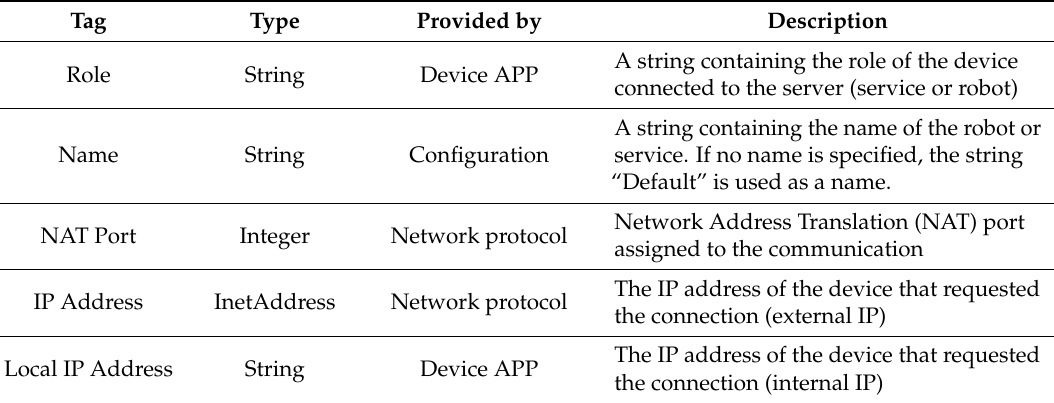
Table 6. Required data to connect with the external